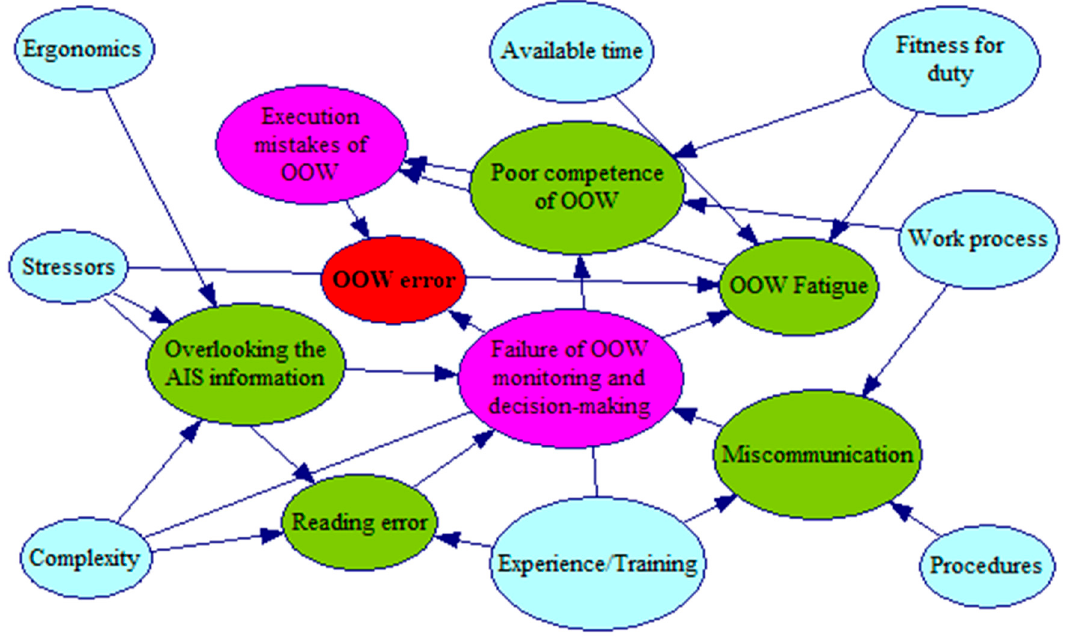
Figure 5. BN model of the OOW’s error.